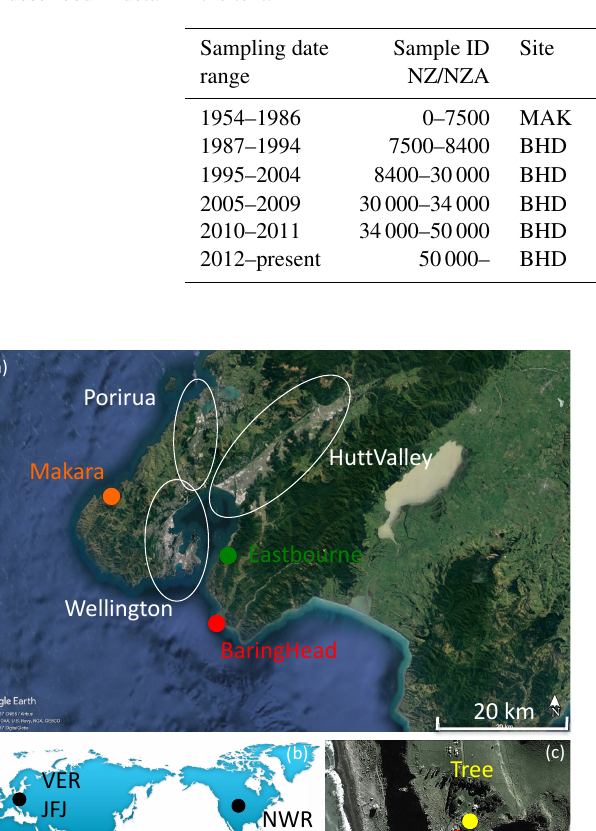
Table 1. Wellington 14 CO 2 measurement methods through time. Gas counting samples are identified by NZ numbers, AMS samples by NZA numbers. NZ and NZA numbers do not overlap. Sites are Makara (MAK) and Baring Head (BHD). Collection and measurement methods are described in detail in the text.